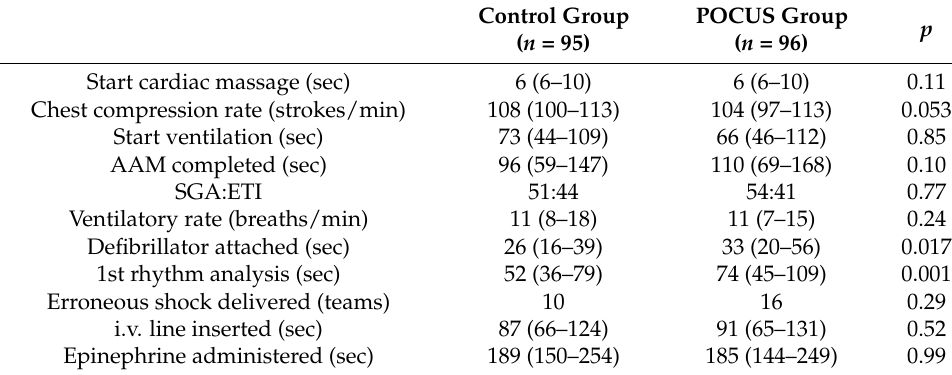
Table 1. Secondary